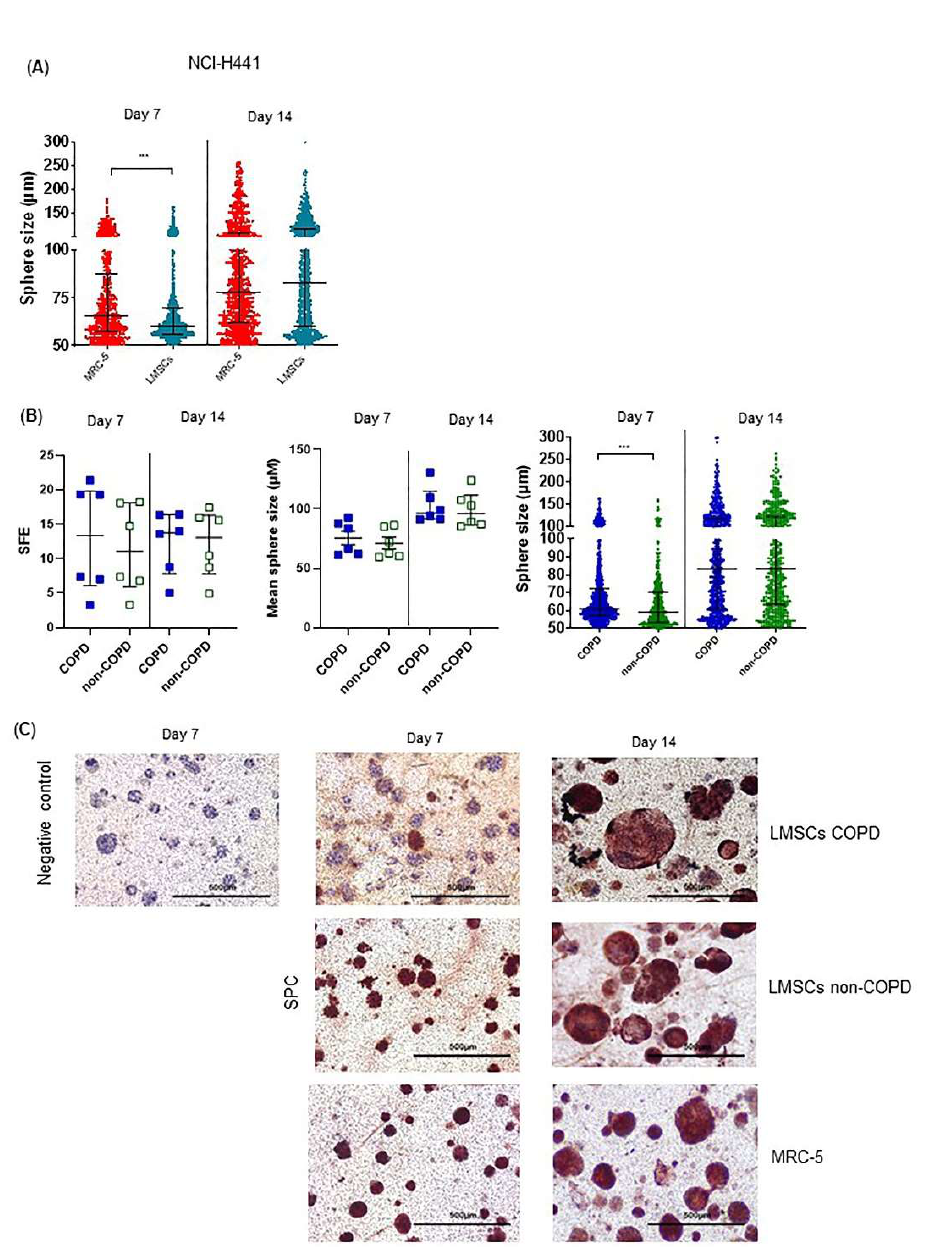
Figure 5. Abnormalities in COPD-derived lung-resident MSCs (LMSCs)-supported organoid formation by NCI-H441 cells. NCI-H441 cells together with mitomycin-treated MRC-5 cells or mitomycin-treated LMSCs from COPD and control do- nors were seeded into 100 µL growth factor-reduced 1:1 diluted Matrigel onto inserts of a transwell and cultured for 7–14 days. The number per well and the size of organoids were measured using light microscopy. The sphere forming efficiency (SFE) was determined as number of organoids normalized by cell input. ( A ) Size of organoids generated in the presence of LMSCs ( n = 12, COPD and control donors combined) or MRC-5 cells. Medians ± IQR are indicated. ( B ) SFE, mean size and size distribution of organoids generated in the presence of COPD ( n = 6) and non-COPD ( n = 6) LMSCs. Medians ± IQR are indicated. ( C ) Inserts were stained with for SPC (using AEC and HE counterstaining). Representative images are shown of 2 independent experiments with 3 non-COPD and 3 COPD LMSC donors per experiment. *** = p < 0.001 between the indicated values as analyzed by the Mann Whitney U